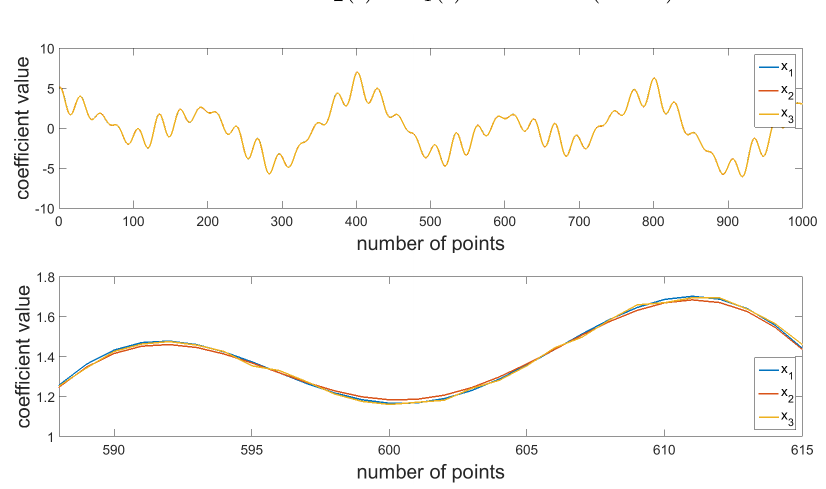
Figure 3. Analyzed surface profiles—simulated tests.